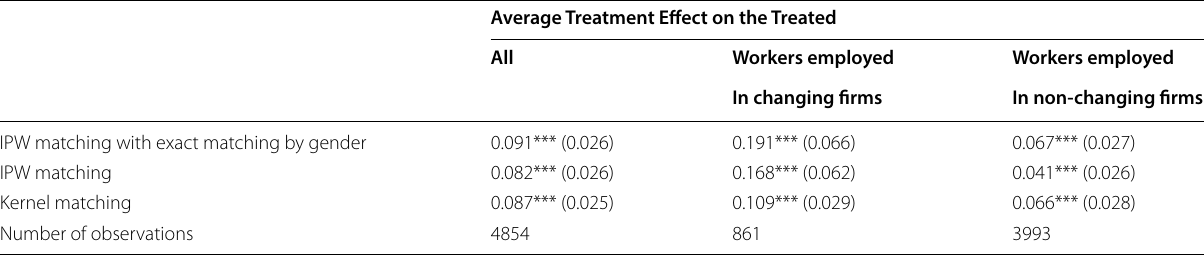
Table 6 Average effect of the participation in a training session regarding the use of new ICT tools on probability of being an internal